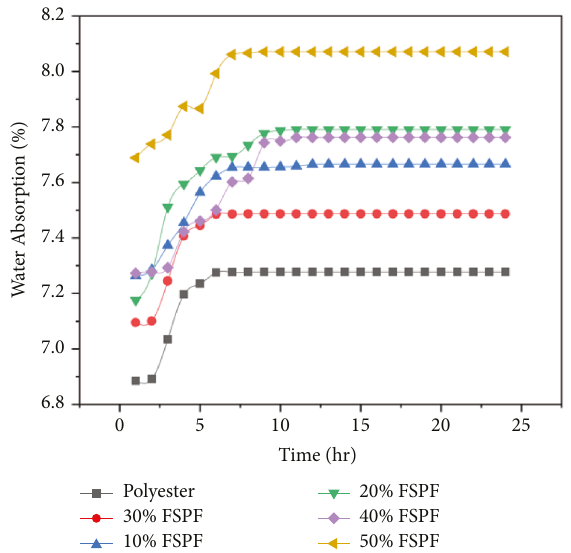
Figure 7: Effect of fiber length and weight percentage on water